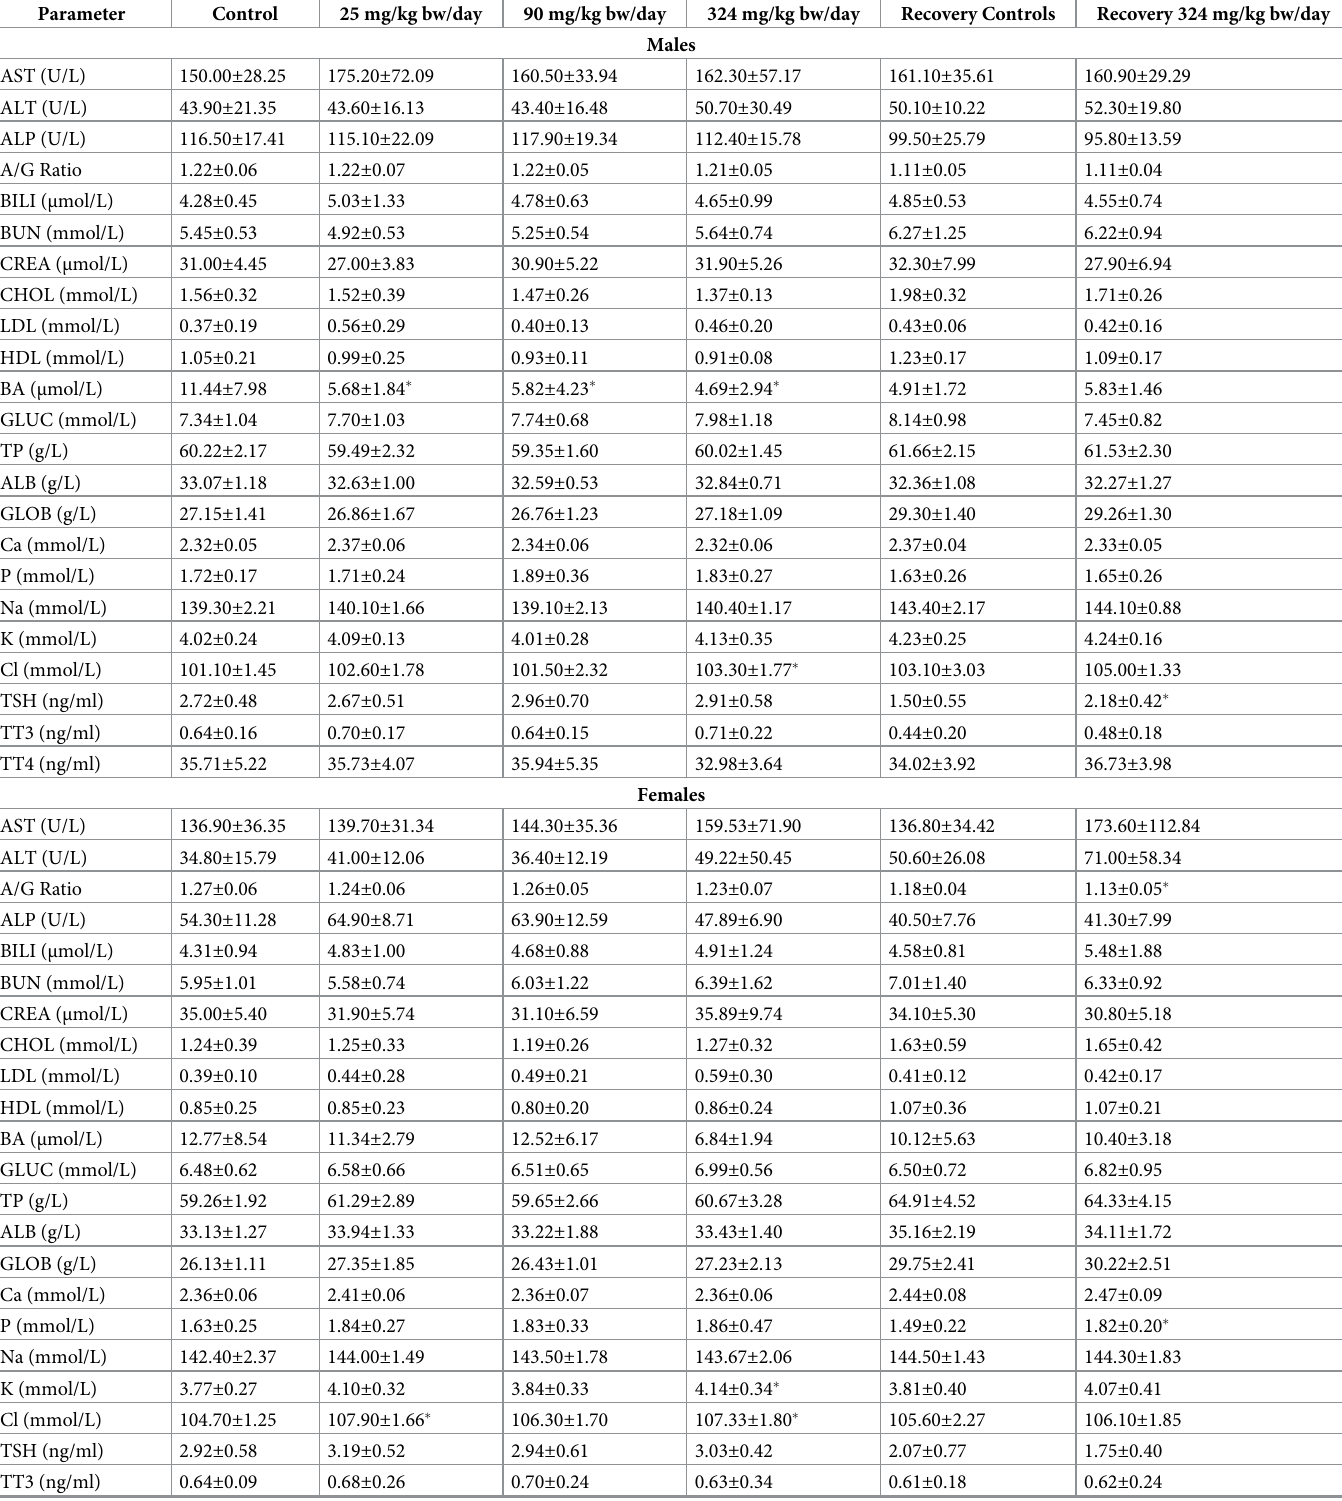
Table 4. Clinical chemistry data for the 90-day study main study and recovery